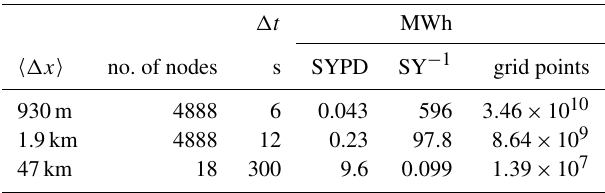
Table 1. Time compression (SYPD) and energy cost (MWhSY − 1 ) for three moist simulations: at 930m grid spacing obtained with a full 10-day simulation, at 1.9km from 1000 steps, and at 47km from 100